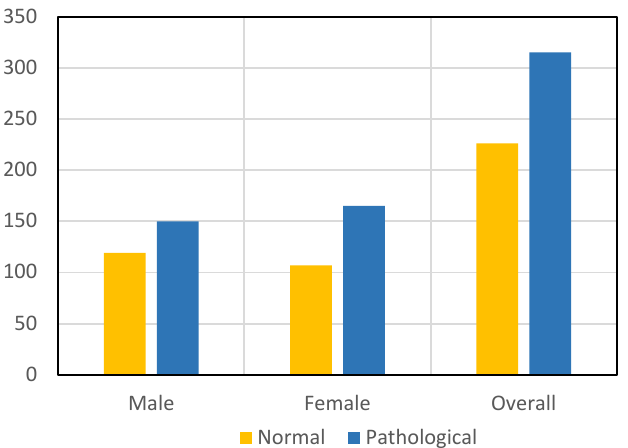
Figure 2. Selected male and female image datasets used for training and validation of the proposed model from the ImageNet database